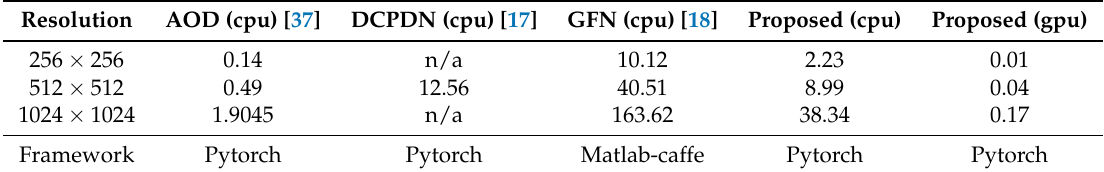
Table 10. Comparative execution times of the dehazing methods